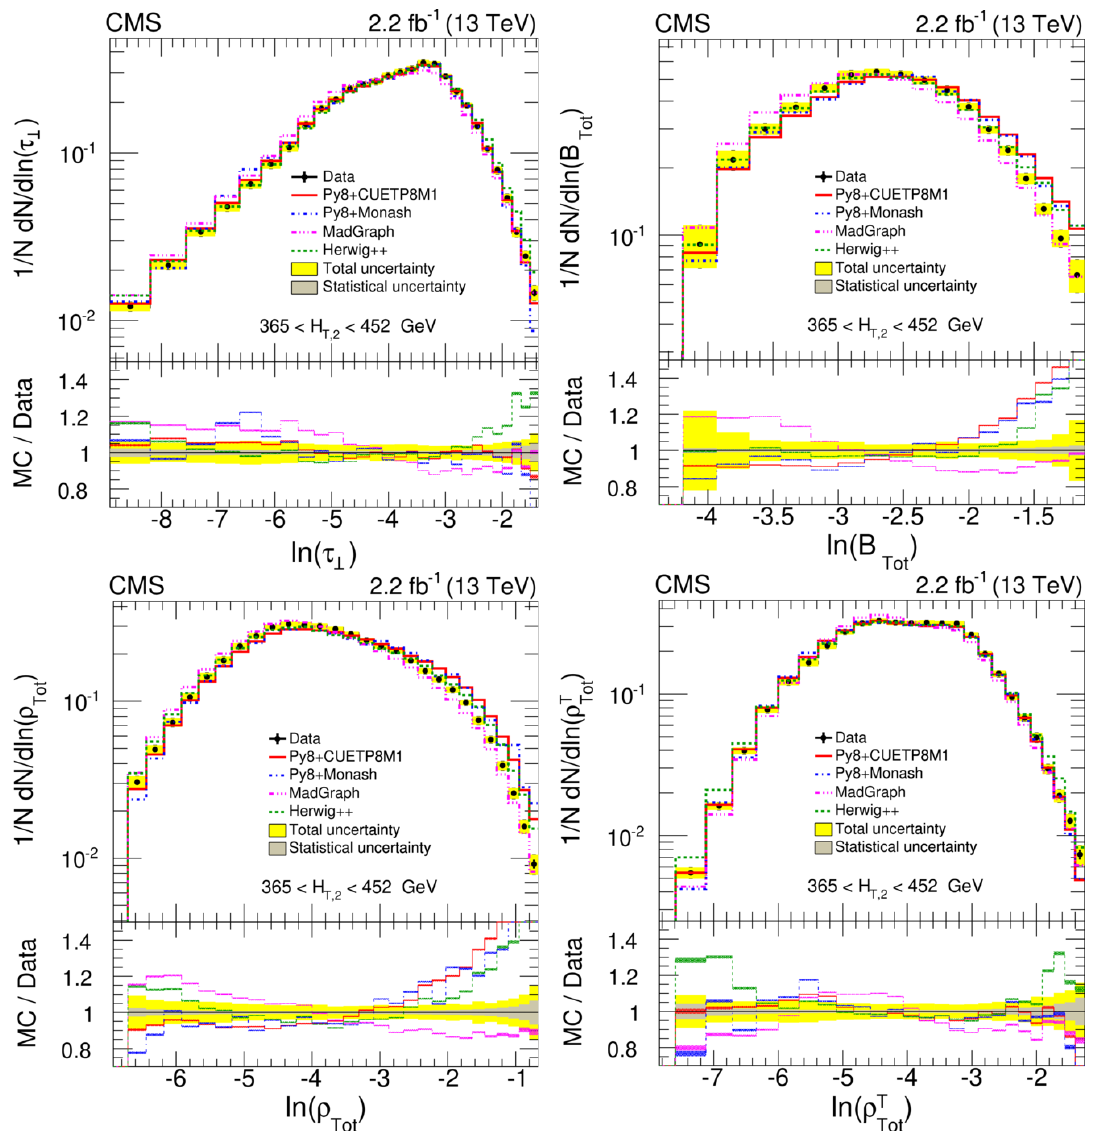
Figure 8 . Normalized di(cid:11)erential distributions of unfolded data compared with theoretical (MC) predictions of pythia 8 CUETP8M1 (red line), pythia 8 Monash (blue dash-dotted line), Mad- Graph 5 a mc@nlo (pink dash-dot-dotted line) and herwig++ (brown dash-dot-dotted line) as a function of ESV: complement of transverse thrust ( (cid:28) ? ) (upper left), total jet broadening ( B Tot ) (upper right), total jet mass ( (cid:26) Tot ) (lower left) and total transverse jet mass ( (cid:26) T 365 < H T ; 2 < 452 GeV. In each ratio plot, the inner gray band represents statistical uncertainty and the yellow band represents the total uncertainty (systematic and statistical components added in quadrature) on data and the MC predictions include only statistical uncertainty.